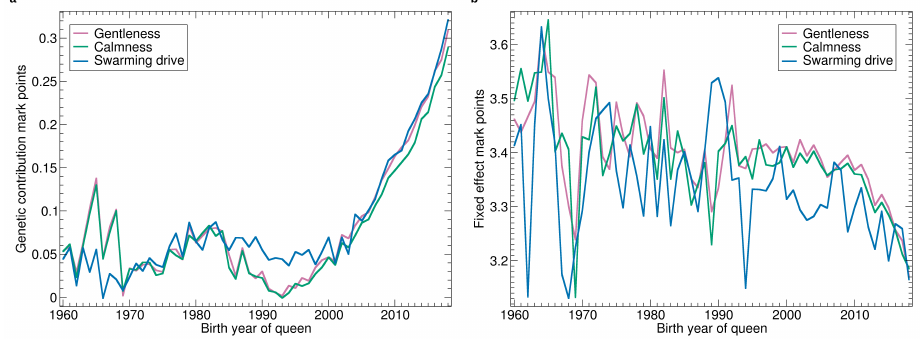
Figure 5. Yearly averages of gentleness, calmness, and swarming drive: ( a ) Progression of the genetic effect. ( b ) Progression of the average apiary effect. The numbers refer to the marks, ranging from 1 (worst) to 4 best. Their differences are called mark points, e.g., the difference between the mark 3.8 and the mark 3.4 are 0.4 mark points.